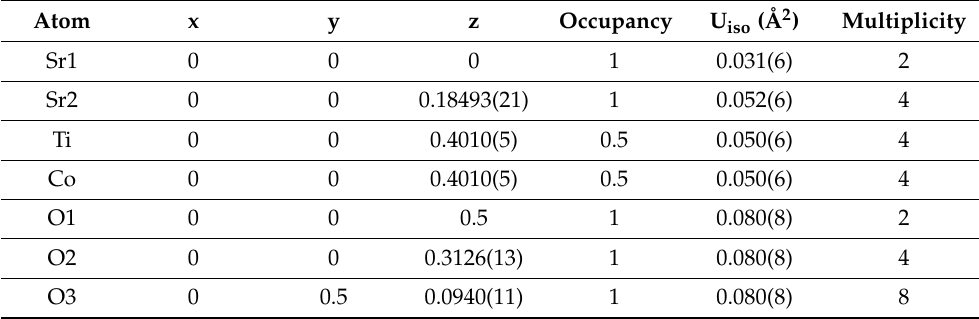
Table 4. Refined structural parameters of Sr 3 TiCoO 7 − δ from powder X-ray diffraction data.